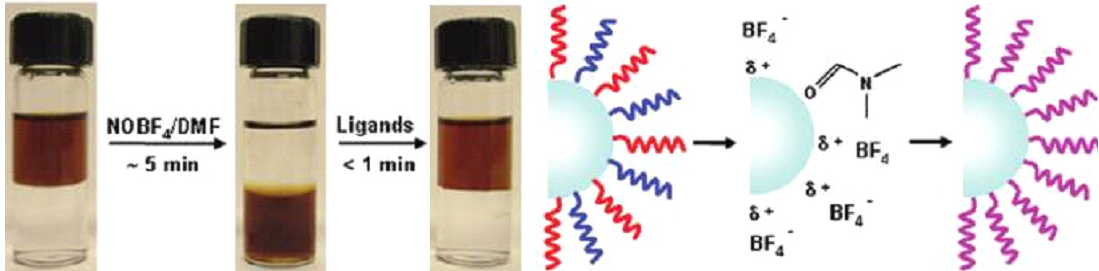
Figure 8. Scheme of the phase transition and ligand exchange procedure by using NOBF 4